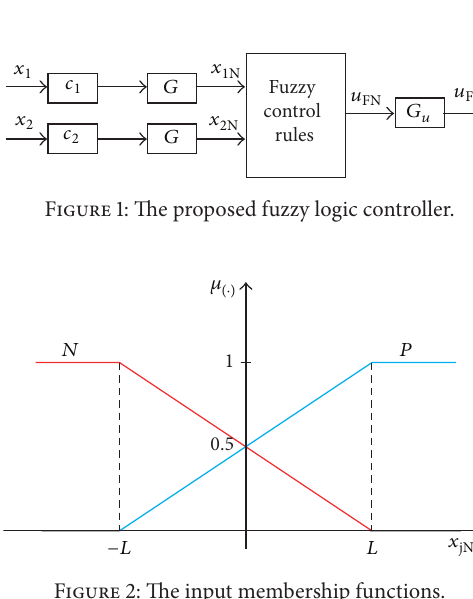
Figure 2: The input membership